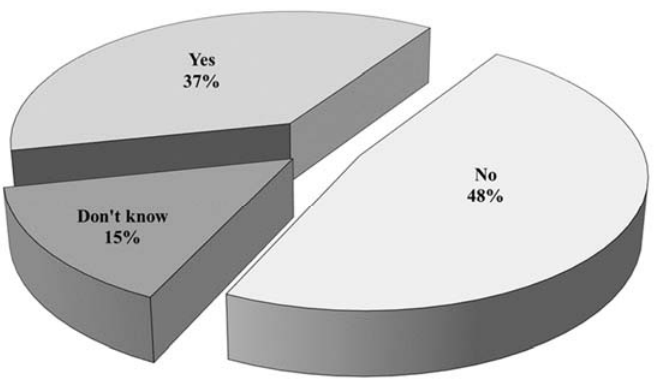
Figure 4. Answers to the question about the relationship between the actual (rated) capacity and the capacity declared on the power bank packaging.